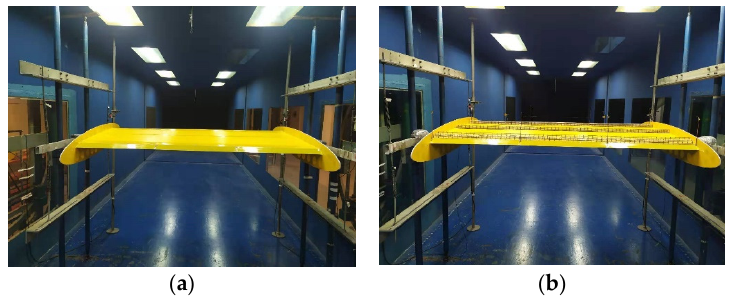
Figure 6. Sectional model in CA-1 wind tunnel. ( a ) Construction; ( b )